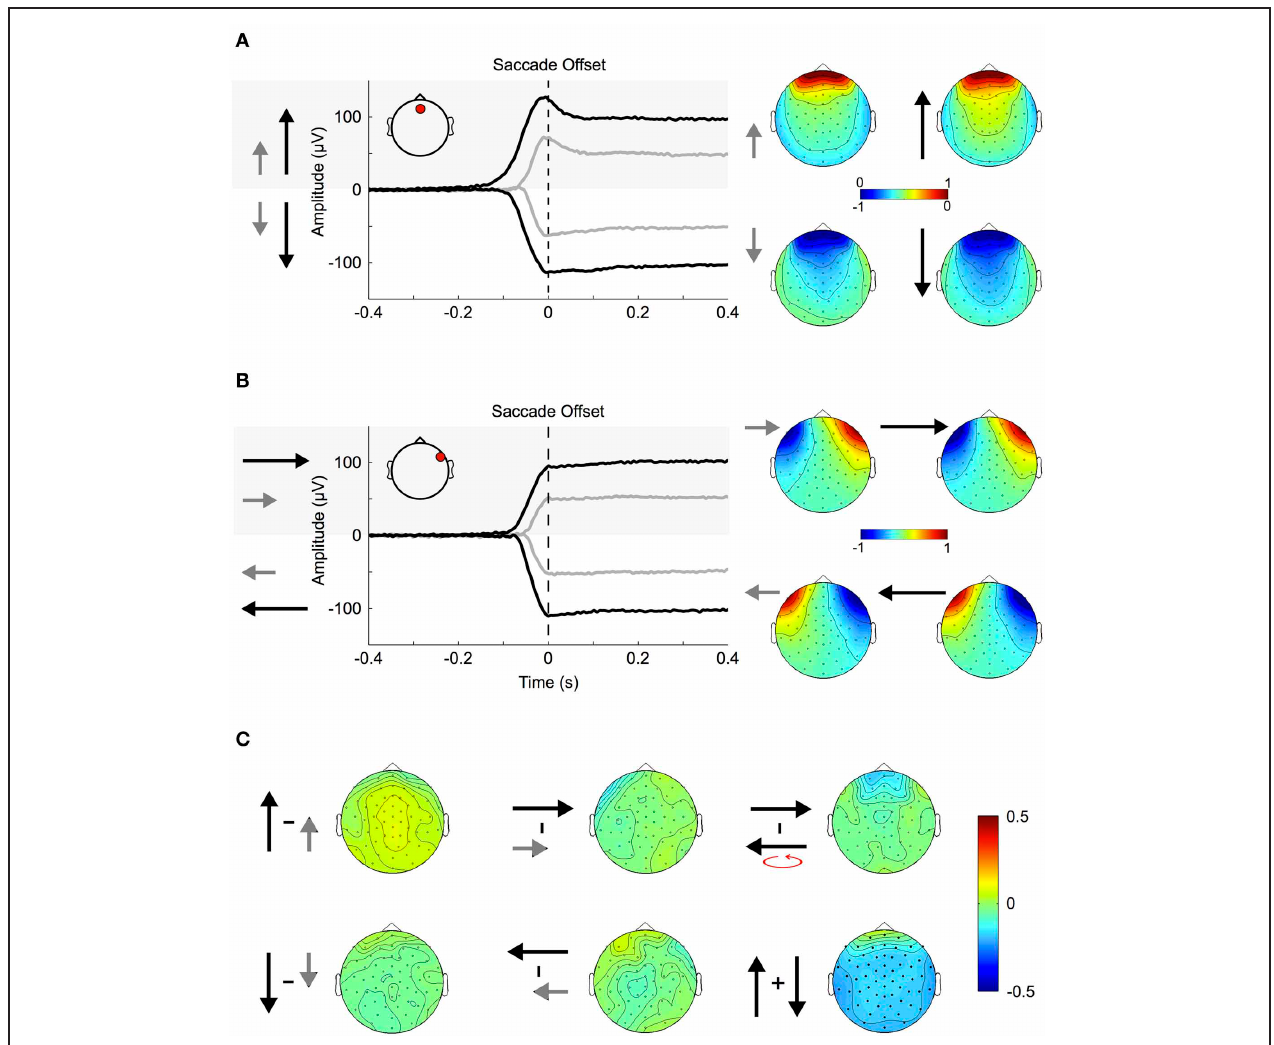
large saccades in the same vertical (left column) and horizontal (middle column) direction do not display any significant differences, indicating that the linear relationship between saccade size and signal offset holds for all electrode sites. The same is observed for horizontal movements of the same size but opposite directions (right column, top). In the vertical dimension, however, downward saccades produce a significantly larger offsets than upward saccades of the same size (right column, bottom; significant electrodes marked by bold black